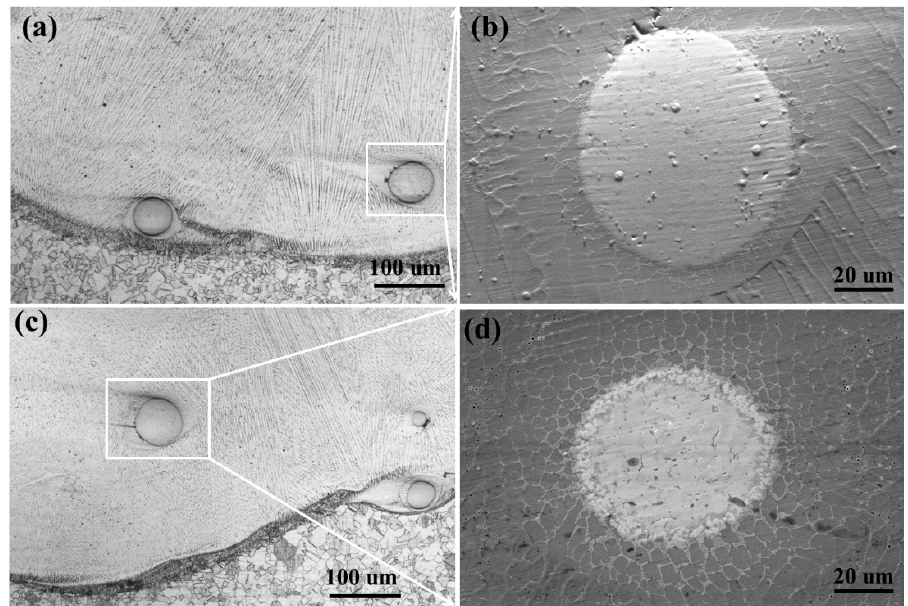
Figure 3. Dendritic morphology of coatings with different compositions ( a ) B coating section with WC particle; ( b ) magnification of B coating section; ( c ) E coating section with WC particle; ( d ) magnification of E coating section.